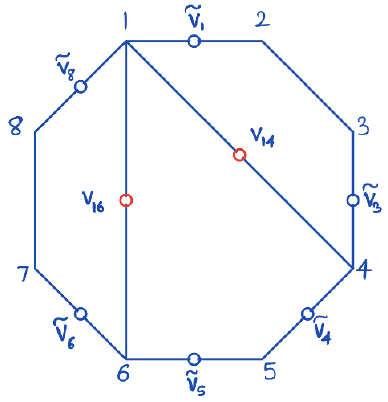
Figure 2 . f 14,16 g quadrangulation of the octagon and the hollow vertices on the external edges and the